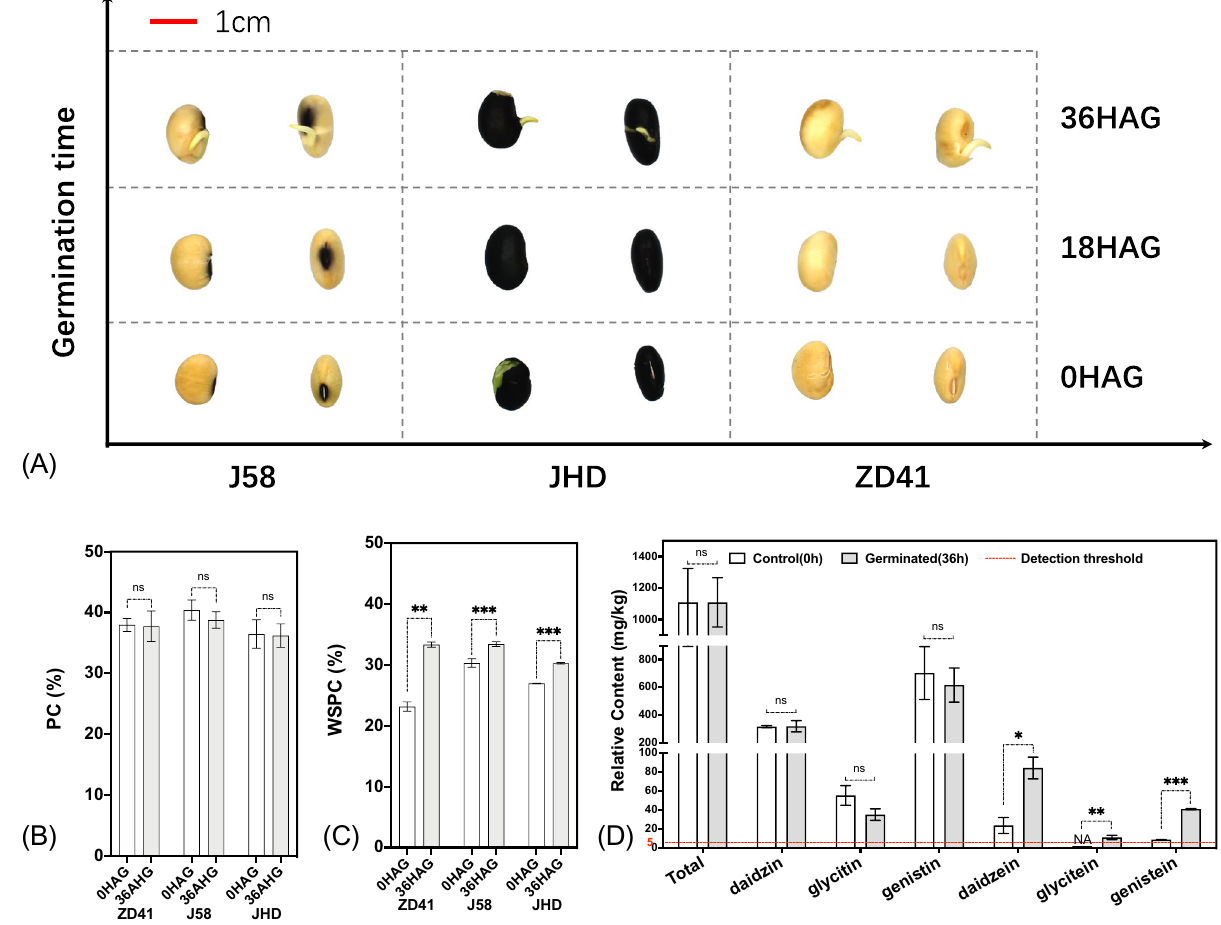
Figure 1. Nutrient alteration in germinated soybean seeds. ( A ) Representative seeds germinated for different time (0 h, 18 h, 36 h); ( B , C ) Protein content (PC) and water soluble protein content (WSPC) in germinated seeds, three independent replicates were performed; ( D ): isoflavone (daidzin, glycitin, genistin, daidzein, glycitein, and genistein) content in germinated seeds of three independent cultivars (ZD41, JHD, and J58) are compared between control (0 h) and germinated for 36 h. *, **, ***, indicates Student’s t -test significant p value of 0.05, 0.01, and 0.001 respectively, ns denotes